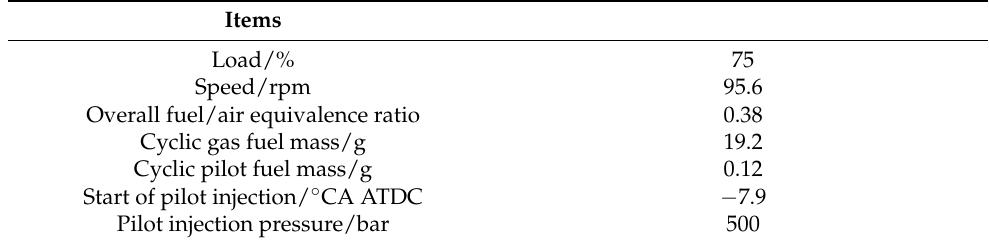
Table 2. Baseline operating conditions.